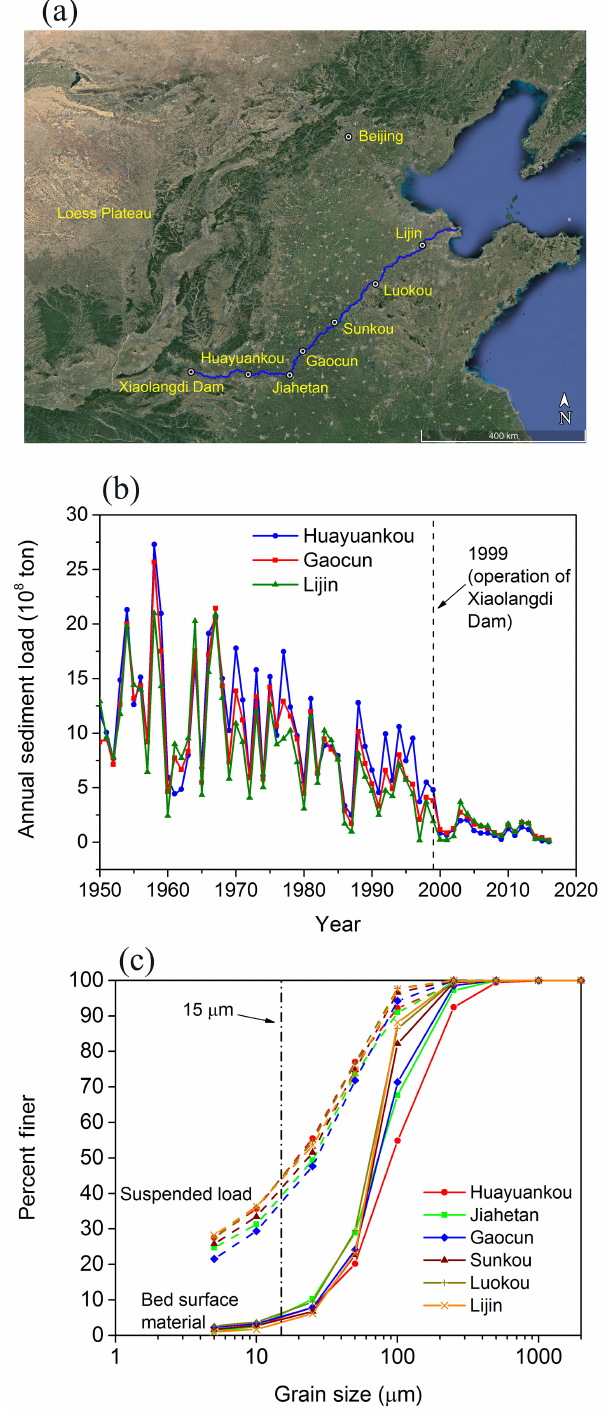
Figure 1. (a) Sketch of the lower Yellow River showing six major gauging stations and the Xiaolangdi Dam. (b) Annual sediment load of the LYR measured at three gauging stations since 1950. (c) Grain size distributions of both bed surface material and suspended load measured at six gauging stations of the